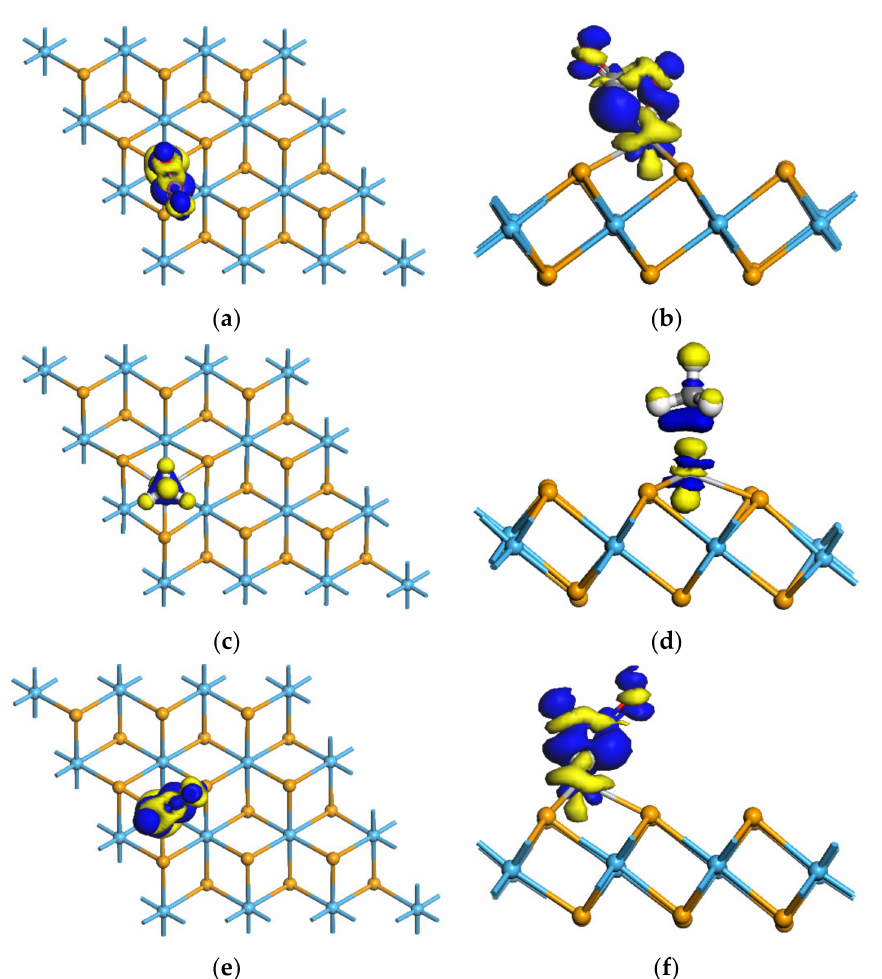
Figure 7. EDD of adsorption system. ( a , b ) EDD of CO 2 with isosurface of 0.04e/Å 3 ; ( c , d ) EDD of CH 4 with isosurface of 0.02e/Å 3 ; ( e , f ) EDD of N 2 O with isosurface of 0.04e/Å 3